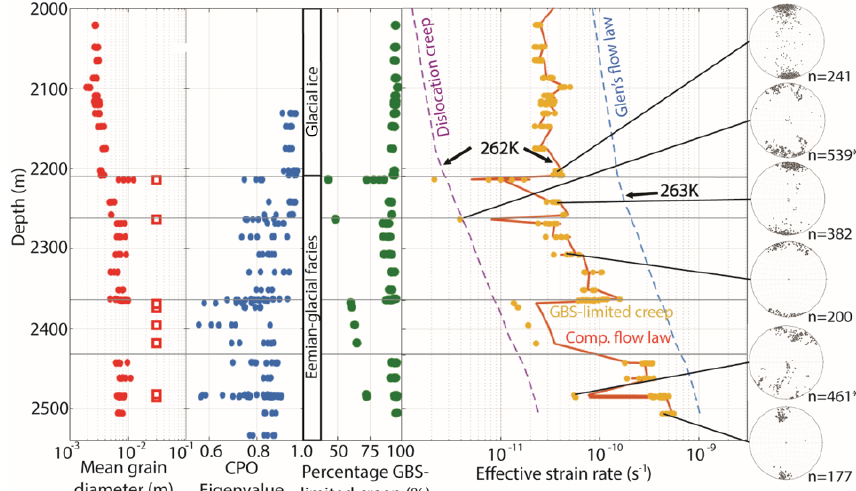
Figure 5. Graphic display of results as a function of depth for the lowest 540m of the NEEM ice core showing (from left to right) the mean grain diameter (red dots), the first CPO eigenvalues (blue dots), the Glacial and Eemian-Glacial facies, the percentage contribution of GBS-limited creep to bulk strain rate (green dots), the calculated strain rates (Table 3) using Glen’s flow law (dotted blue line), the modified composite flow law (orange line), and the two deformation mechanisms of the Goldsby and Kohlstedt flow law, one showing dislocation creep (dotted purple line) and the other showing GBS-limited creep (yellow dots). Note that the orange line shows the total strain rates made up of the dislocation creep strain rate (shown by the purple line) and the GBS-limited strain rate (shown by the yellow dots). An open red square instead of a red dot was used when the grain size was too large to determine a mean grain diameter using the Ice-image software and a mean grain diameter of 30mm was used. The four horizontal grey lines represent the stratigraphic disruptions that were found in the NEEM deep ice core (NEEM community members, 2013). The Glacial ice extends to a depth of 2207m, with the Eemian-glacial facies continuing down to the ice–bedrock interface at 2540m depth. The depth of the temperature threshold for the modified composite flow law (262K) and Glen’s flow law (263K) are indicated. On the far-right six pole figures are shown (equal area, vertical plane, one point per grain) with the number of grains ( n , next to the pole figure). At two depths, indicated by an asterisk (*), the CPO data from six consecutive ice core sections were combined to increase the number of grains in the pole figure. Pole figures were taken from Weikusat and Kipfstuhl (2010)